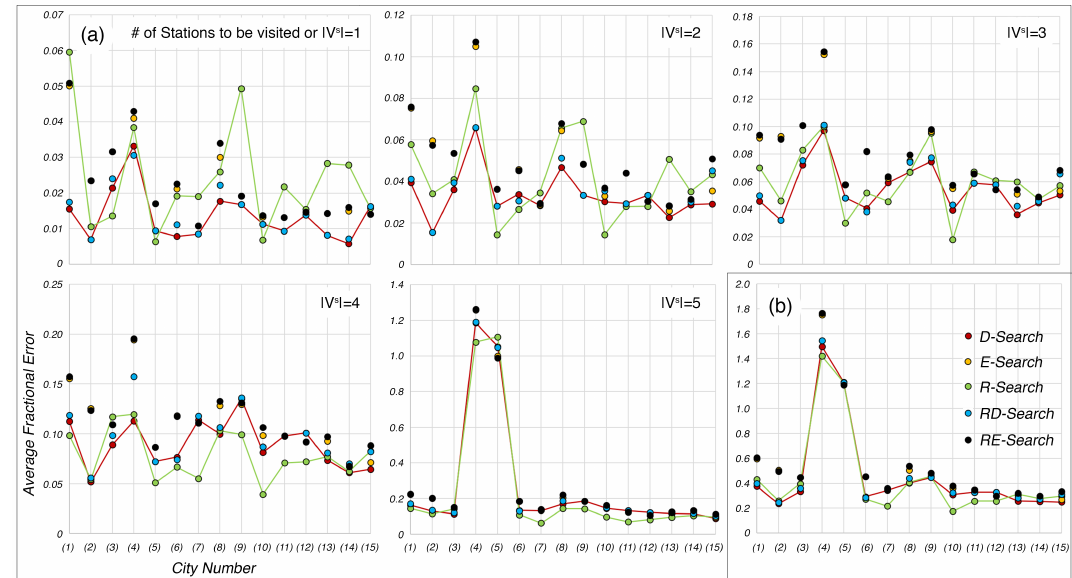
Figure 5. ( a ) scatter plot between the Average Fractional Error and the City Number (representing city, Table 1) for all | V s | instances. Nodes belonging to the D-Search and R-Search are joined together to allow comparison. It can be seen that, for lower | V s | instances, the D-Search is better than the R-Search, and vice-versa for higher | V s | instances, as also reported in Figure 4; ( b ) the y -axis represents the summation of Average Fractional Error from all | V s | instances. It is said that the R-Search is overall the best search criterion to perform a geospatial E-GTSP to TSP conversion.